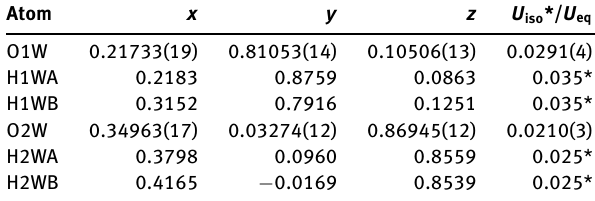
Table 2: Fractional atomic coordinates and isotropic or equivalent isotropic displacement parameters (Å 2